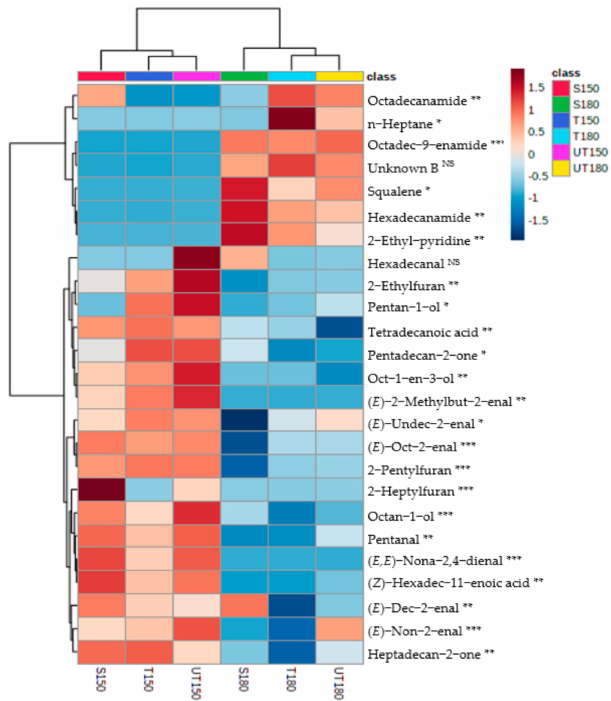
Figure 2. Heatmap generated with normalized data for the top 25 molecules responsible for the differences between the profiles. Each column corresponds to a studied modality. Red and green squares indicate VOC profiles obtained for sow fat heated at 150 and 180 ◦ C, dark blue and light blue represent VOC profiles for tainted boar fat heated at 150 and 180 ◦ C, and lastly, pink and yellow dots represent untainted fats at 150 and 180 ◦ C, respectively. Results of ANOVAs are represented after the molecule name: NS indicates a p -value > 0.05 while *, **, *** indicate p -values < 0.05, <0.01, and <0.001